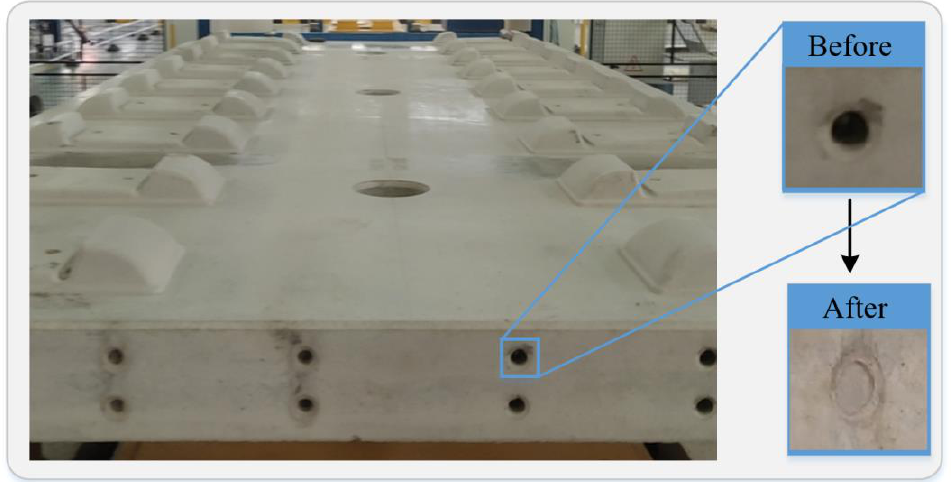
Figure 1. CRTS-III slab ballastless track plate without anchor sealing and anchor hole pattern before and after anchor sealing.